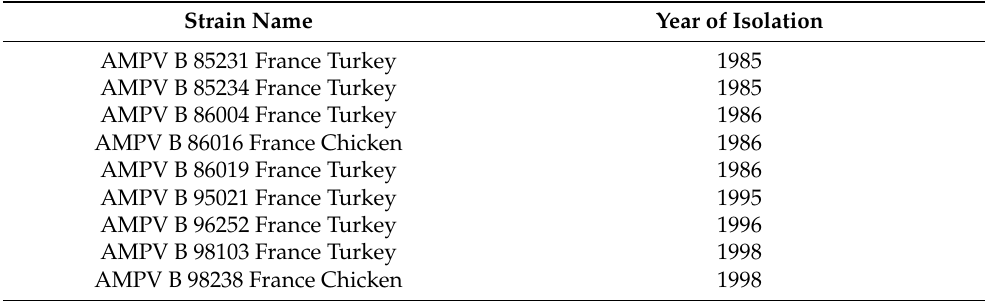
Table 2. Details of historical French aMPV-B strains detected from 1985 to 1998 by the Laboratoire de Ploufragan